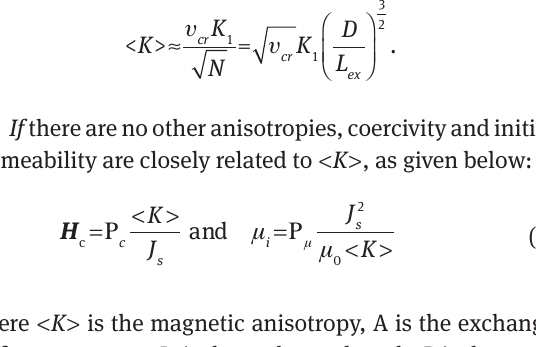
Figure 6 Changes of B annealed at 793 K for 120 s (Kong et al. [14], Copyright AIP